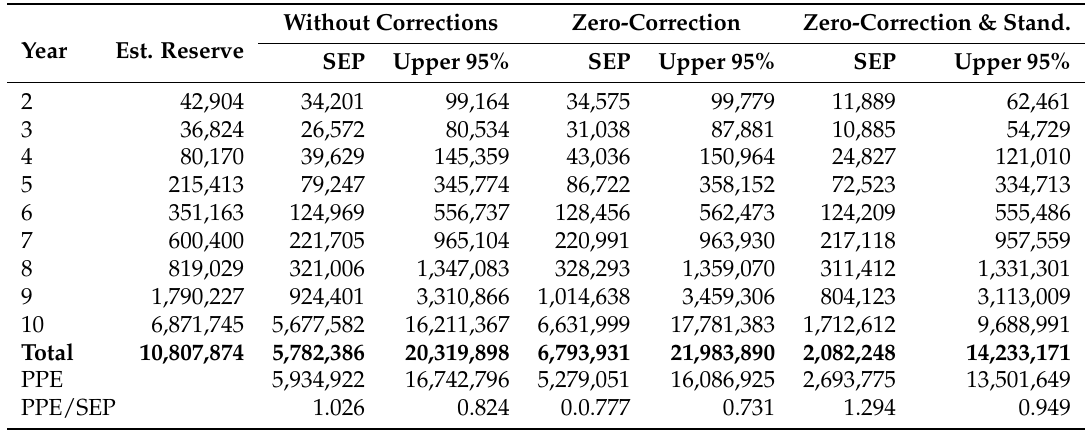
Table 7. Log-normal model with Anscombe